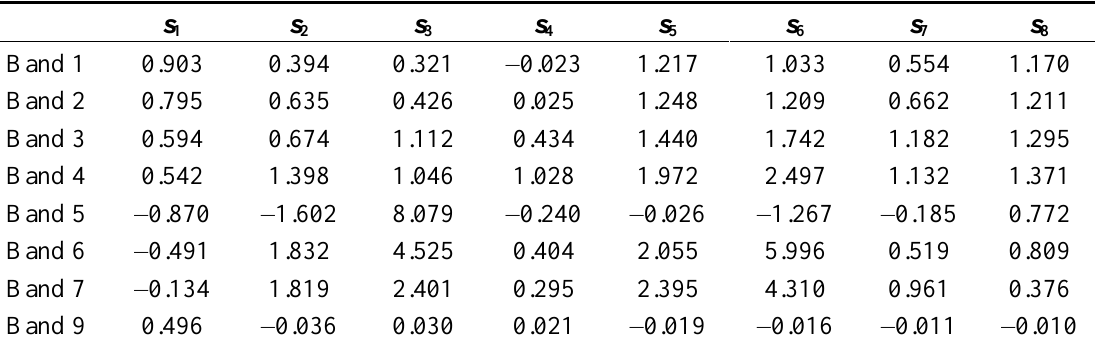
Figure 3. ( a – h ) are first, second, …, and eighth independent components, respectively. Table 1. Coefficients (×10 −2 ) of A